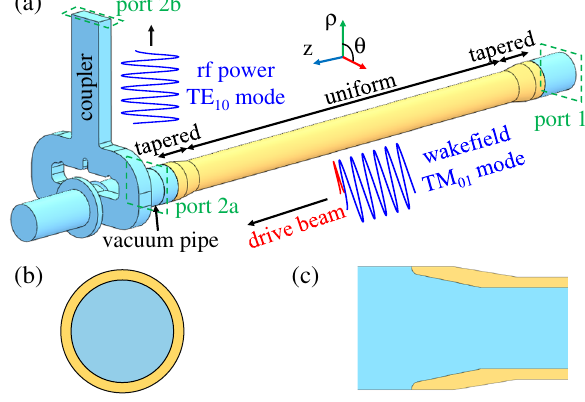
FIG. 1. Dielectric-loaded power extractor. Yellow and blue denote the dielectric and vacuum regions, respectively. The copper, which covers the outside of the whole structure, is not shown. The drive beam travels through the center of the dielectric tube along the z -axis. (a) Layout of the whole structure. (b) Transverse cross section of the uniform dielectric section. (c) Longitudinal cross section of the tapered dielectric matching